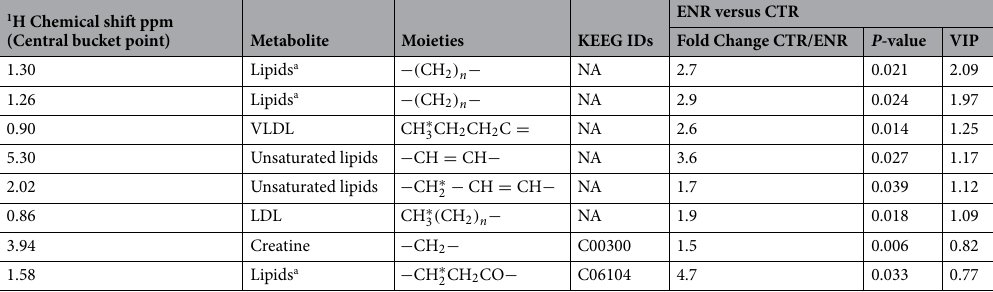
Table 2. Key metabolites that differentiate serum of enriched piglets (ENR) from control (CTR) piglets at post-weaning period. P -values were derived from Student’s t -test. Variable importance in the projection (VIP) value was derived from OPLS-DA with a threshold of 0.75. a Triglycerides and fatty acids. VLDL: very low- density lipoprotein; LDL: low density